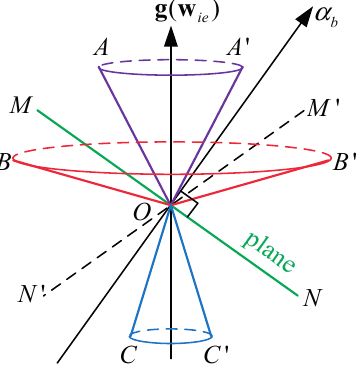
α -axis and ( ) g w . The b ie